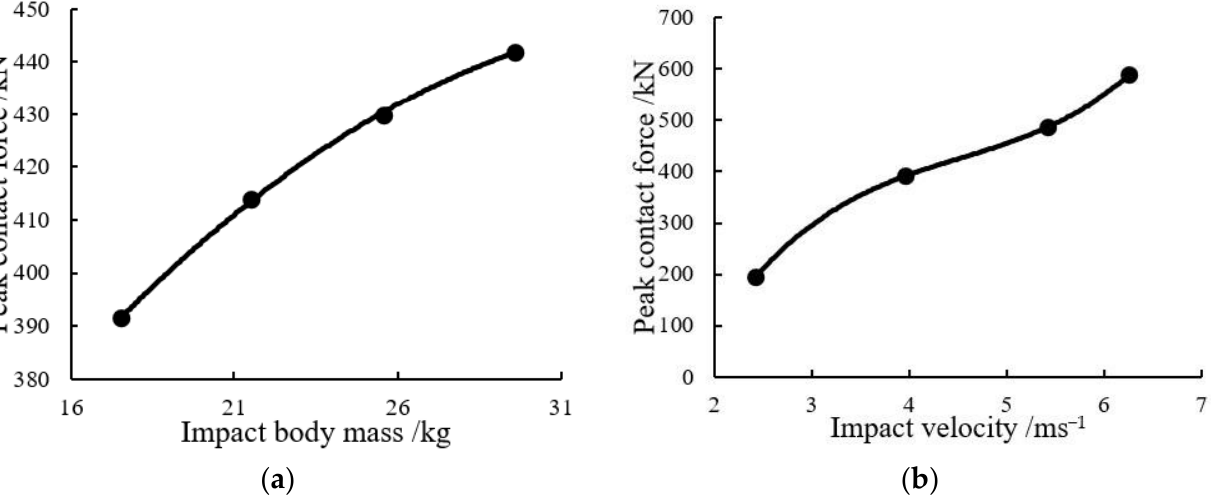
Figure 18. Relationships among peak contact force, impact mass, and impact velocity: ( a ) relationship between peak contact force and impact mass; ( b ) relationship between peak contact force and impact velocity.